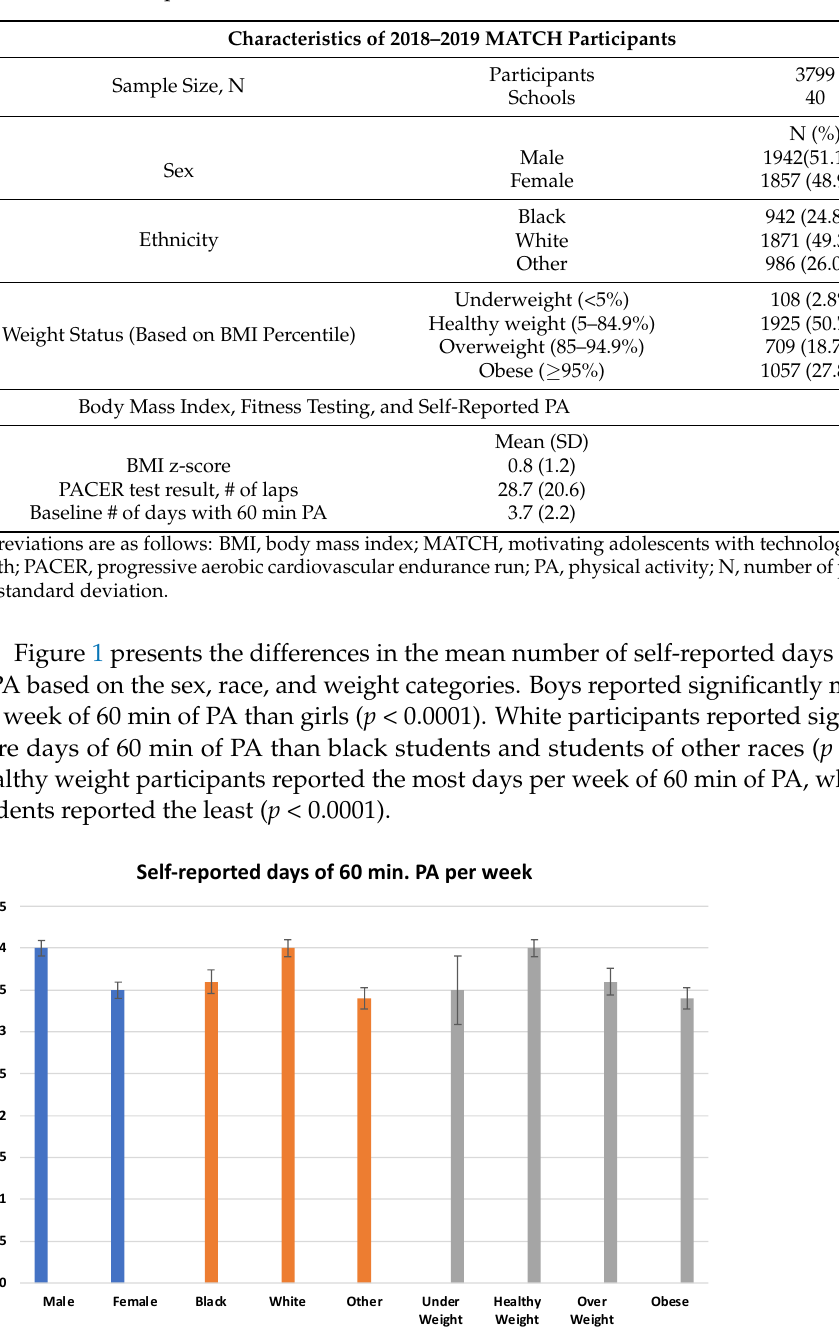
Table 2. Characteristics of 2018–2019 MATCH participants and baseline BMI z-score, fitness testing (PACER), and self-reported PA.